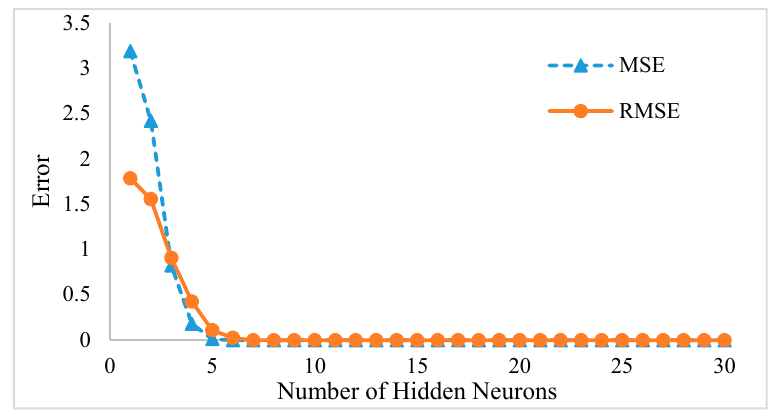
Figure 4. FFNN error results with a different number of hidden nodes.